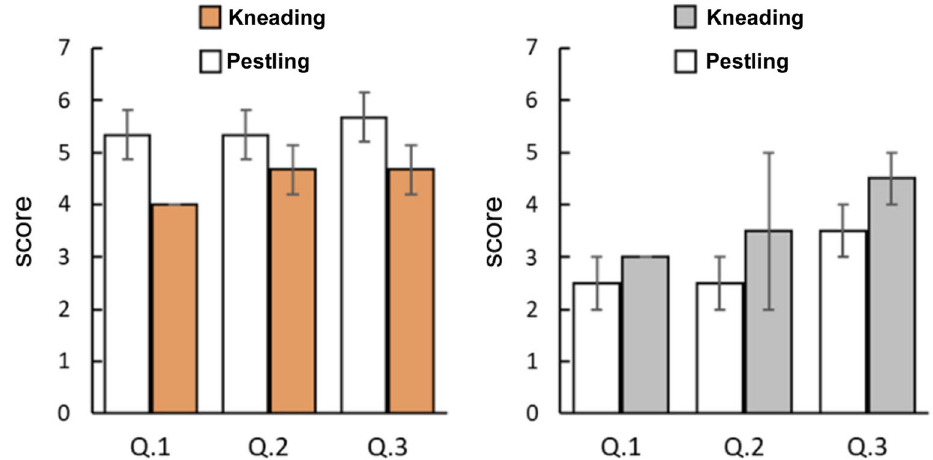
Fig. 4 Qualitative evaluation questionnaire results. Left: implicit pairs. Right: explicit